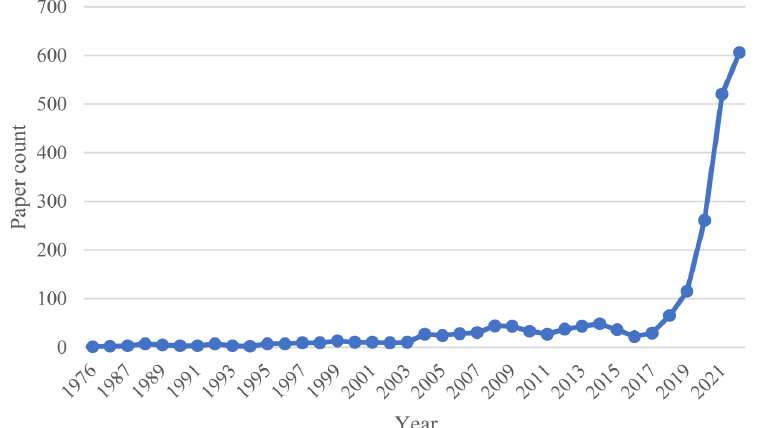
Figure 2. Number of XAI publications added per year from 1976 to 2021. The x axis represents the publishing year, and the y axis shows the number of publications added in a certain year. The number of publications indexed on PubMed (accessed on 1 July 2022: https://pubmed.ncbi.nlm.nih.gov) that matched the search queries related to explainable AI topics in this survey with a term searched of (explainable AI OR explainable artificial intelligence) AND (medicine OR